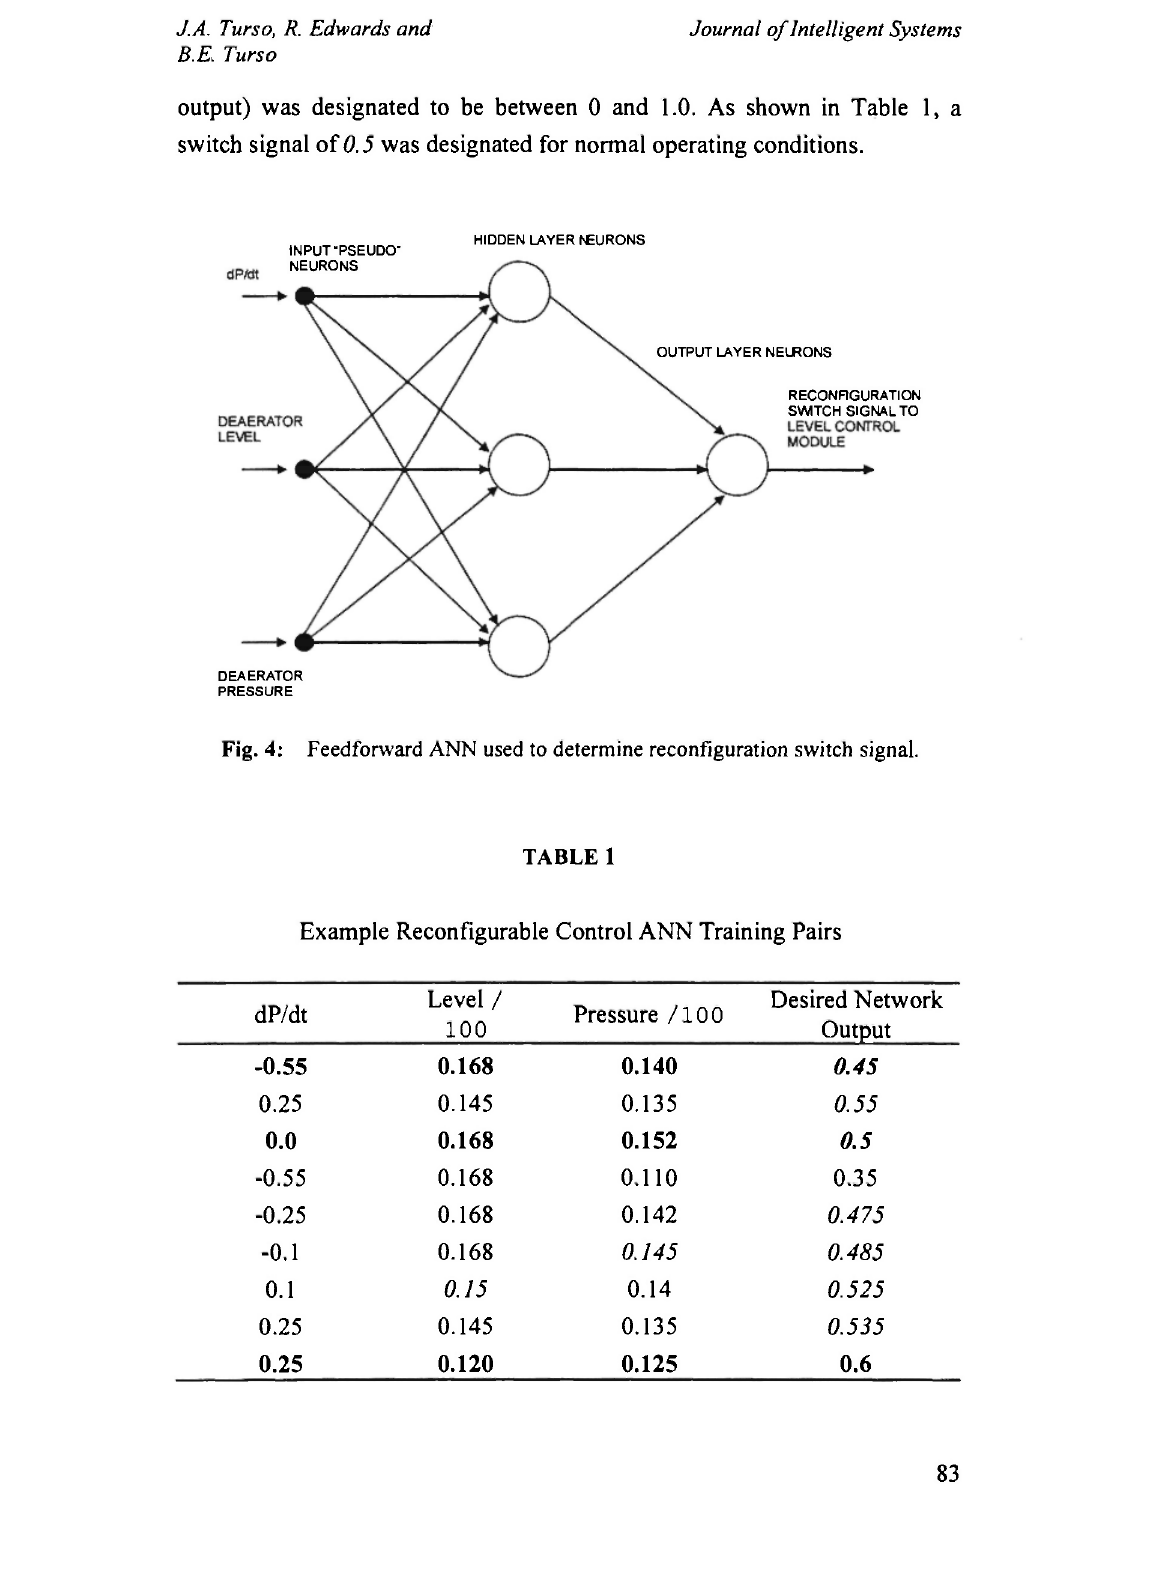
Fig. 4: Feedforward ANN used to determine reconfiguration switch signal.